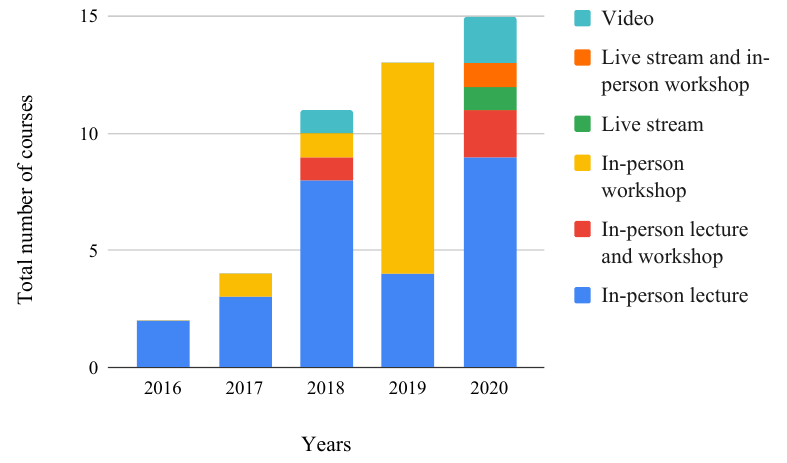
Figure 9. A trend of instructional modes from 2016 to 2020.